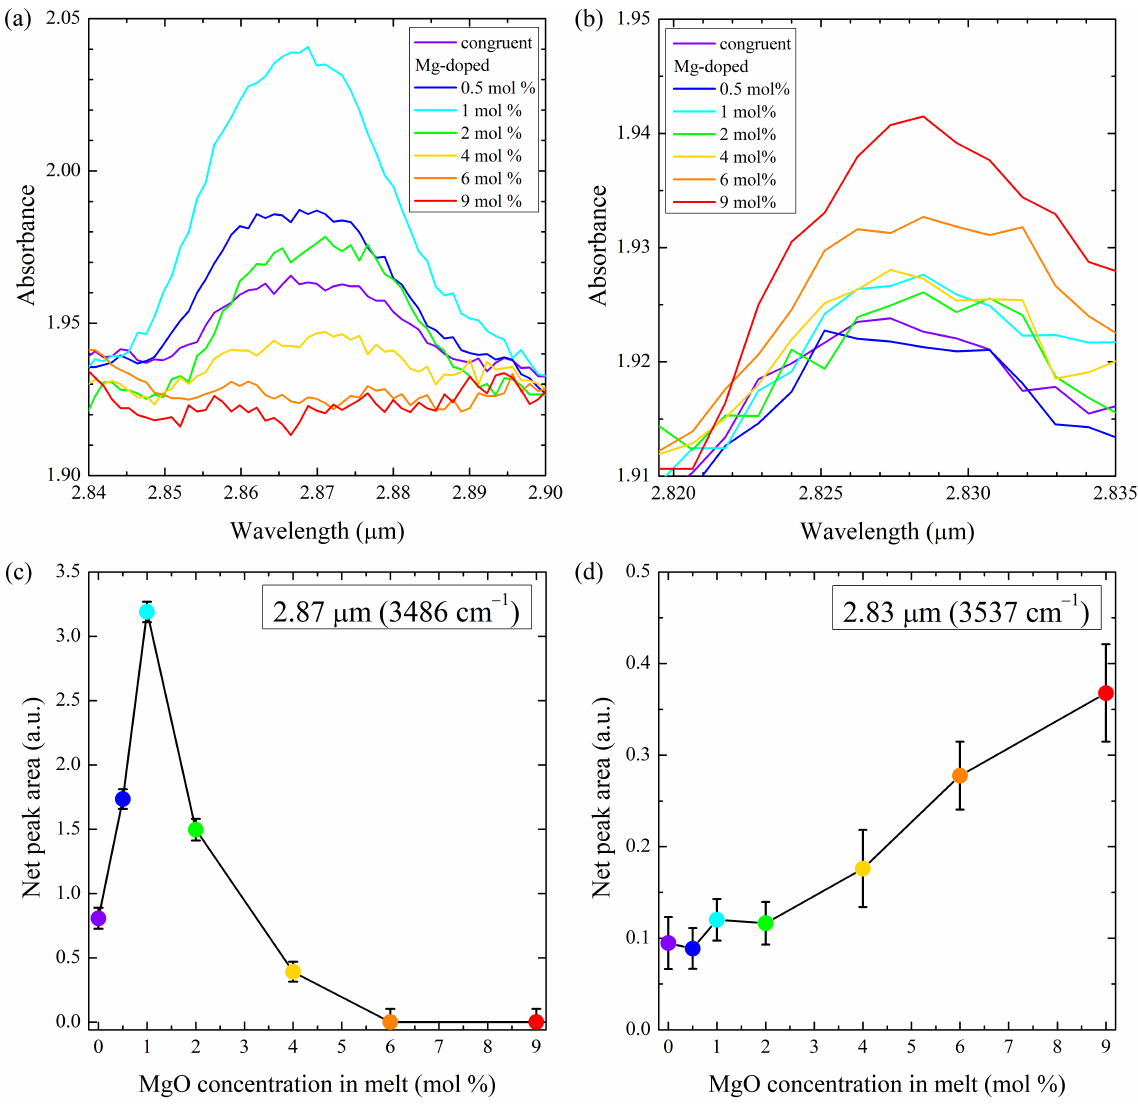
Figure 1. ( a , b ) Infrared absorption bands at 2.87 µ m and 2.83 µ m for congruent and Mg-doped lithium niobate samples. ( c , d ) Areas under the respective absorption peaks in dependence of the MgO concentration in the crystals. The symbol colors correspond to the line colors used in the upper